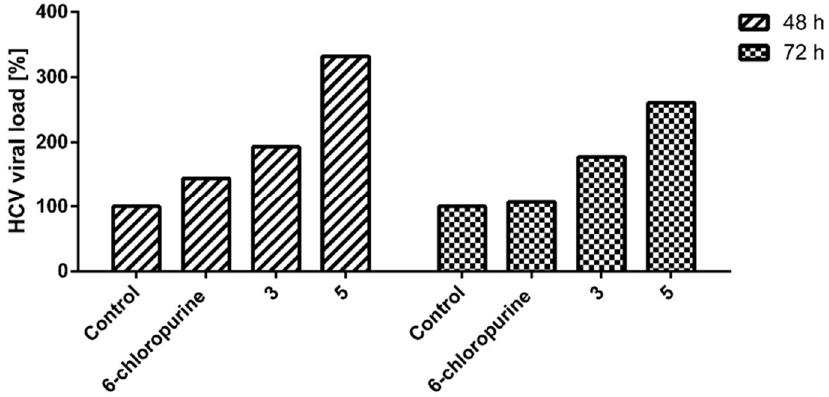
Figure 4. Effect of compound 3 (25.00 µM), 5 (25.00 µM), and 6-chloropurine (25.00 µM) on the viral load of HCV in Huh7.5 SG cells at 48 and 72h.